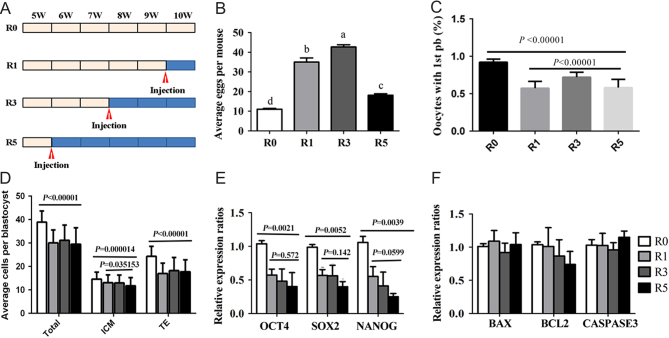
Effects of multiple superovulations on embryonic development. (A) Schedule of superovulation; (B) average number of eggs retrieved from each mouse after mating with males; (C) the incidence of oocytes with the 1st PB; (D) the cell number of blastocysts. The number of blastocysts tested was 67, 73, 64 and 74 in R0, R1, R3 and R5 groups, respectively. (E and F) Effects of multiple superovulations on embryonic quality were also examined via checking the expression of the genes, such as pluripotency-related genes Oct4, Sox2, Nanog and apoptosis-related genes Bcl2, Bax and Casp3.